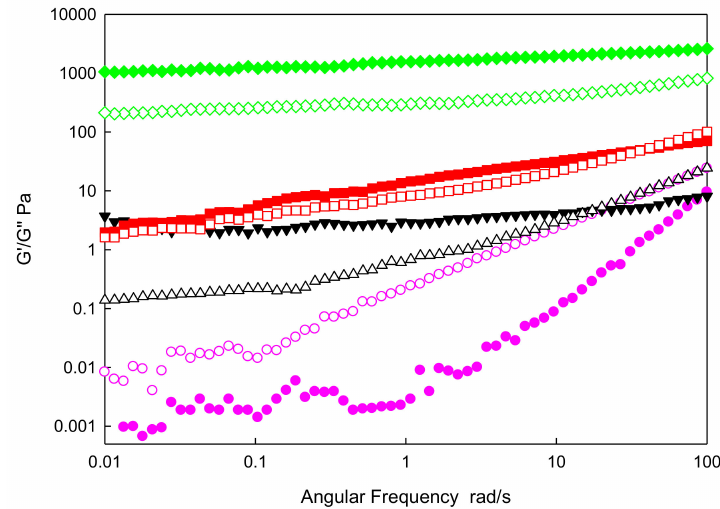
Figure 7. Store (G (cid:48) , solid symbols) and loss (G”, empty symbols) moduli versus angular frequency at 293.15K for: xGnP / [C 2 C 1 py][C 4 F 9 SO 3 ] at mass concentrations: (circle — ) 0 wt%; (triangle — ) 1 wt%; (square — ) 5 wt%; and (diamond — ) 10